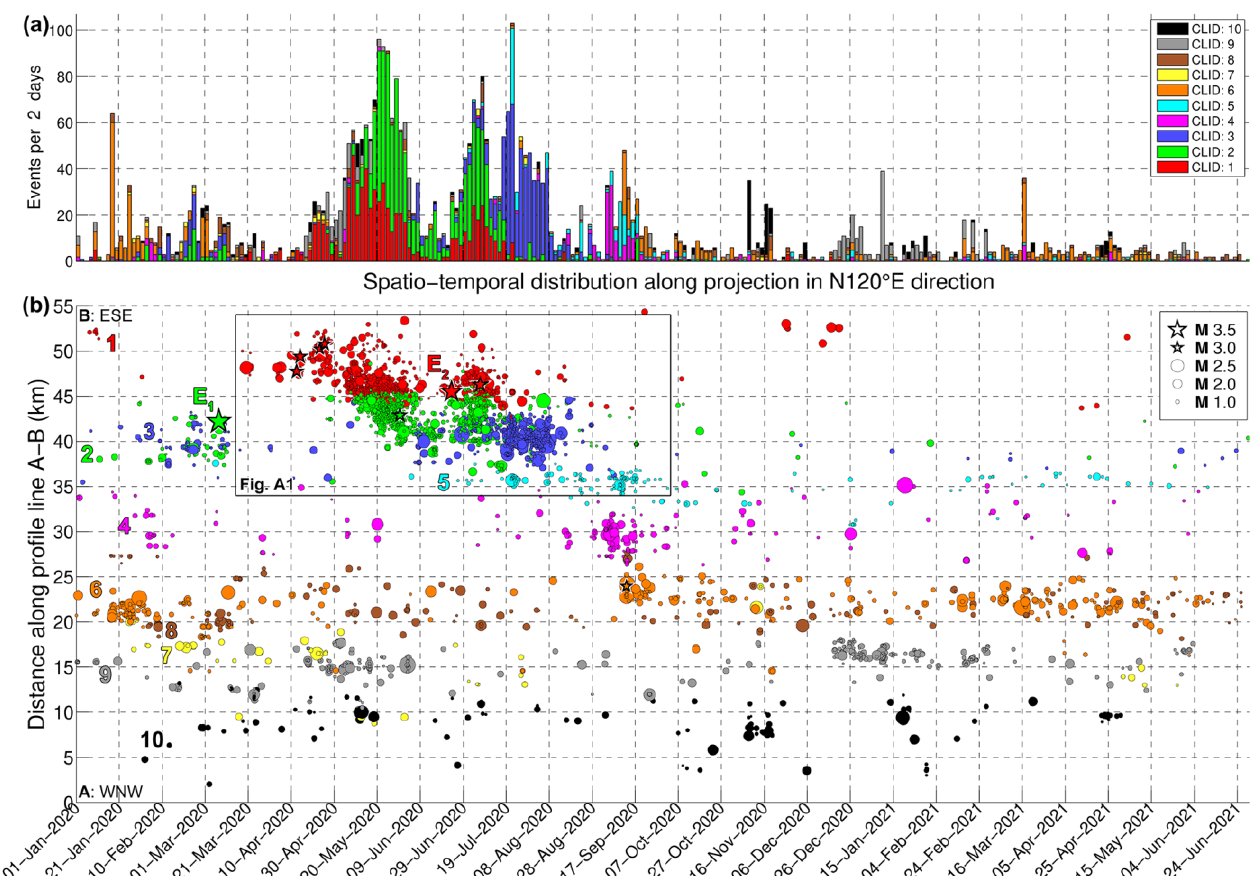
Figure 9. ( a ) Stacked histogram of the number of events per two days for events of CAT3 with magnitude M ≥ 0.5. ( b ) Spatiotemporal projection of the epicenters along the WNW – ESE-oriented (N120°E) A – B profile of Figure 3a. Colors and numbers (panel ( b )) correspond to the spatial groups of Figure 3a (CLID = Cluster ID). Events with magnitude M ≥ 3.0 are represented by stars. The major events E 1 and E 2 are marked in panel ( b ). The rectangle in panel ( b ) shows the boundaries of